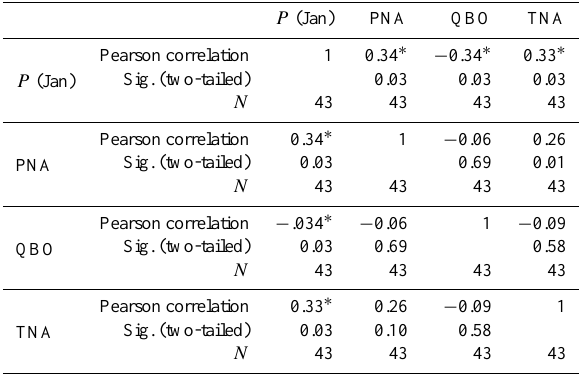
Table 4. Correlation matrix between January precipitation and se- lected indices.